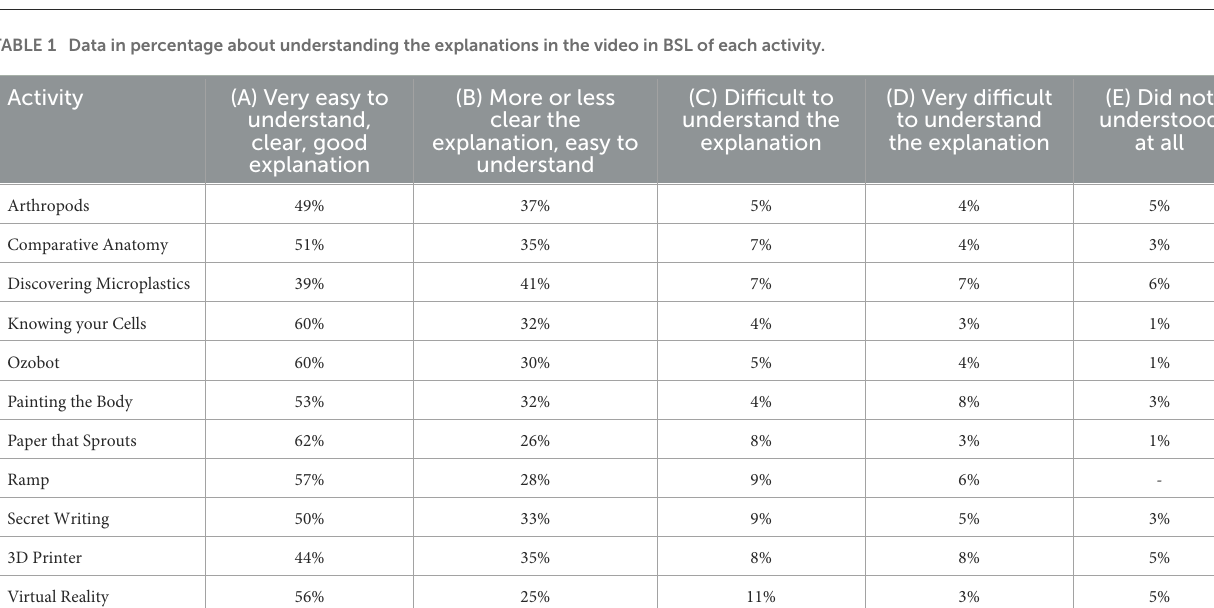
FIGURE4 Percentual data about understanding the explanations in the video in BSL n = 745.